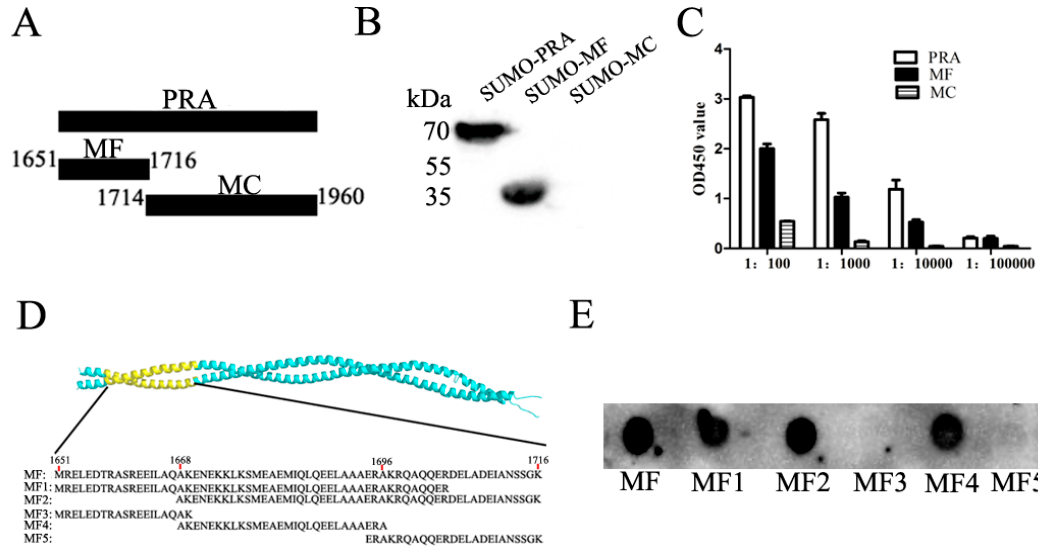
Figure 1. Determination of the binding site for Mab2-5G2 on MYH9. ( A ) Schematic illustration of PRA truncations: MF (aa 1651–1716) as the N-terminal of PRA and MC (aa 1714–1960) as the C-terminal of PRA. ( B ) Western blot analysis of PRA and truncated PRA fragments MF and MC using Mab2-5G2. ( C ) ELISA analysis of MF or MC binding to plate wells coated with Mab2-5G2 with PRA protein included as a positive control. ELISA data were presented as the mean ± SD. ( D ) Schematic illustration of peptide-binding locations mapped to the full-length MF fragment of the PRA region. ( E ) Dot blot assay using 5 µg of MF, MF1, MF2, MF3, MF4, and MF5 peptides applied to the blot and tested for binding to Mab2-5G2 as primary antibody.